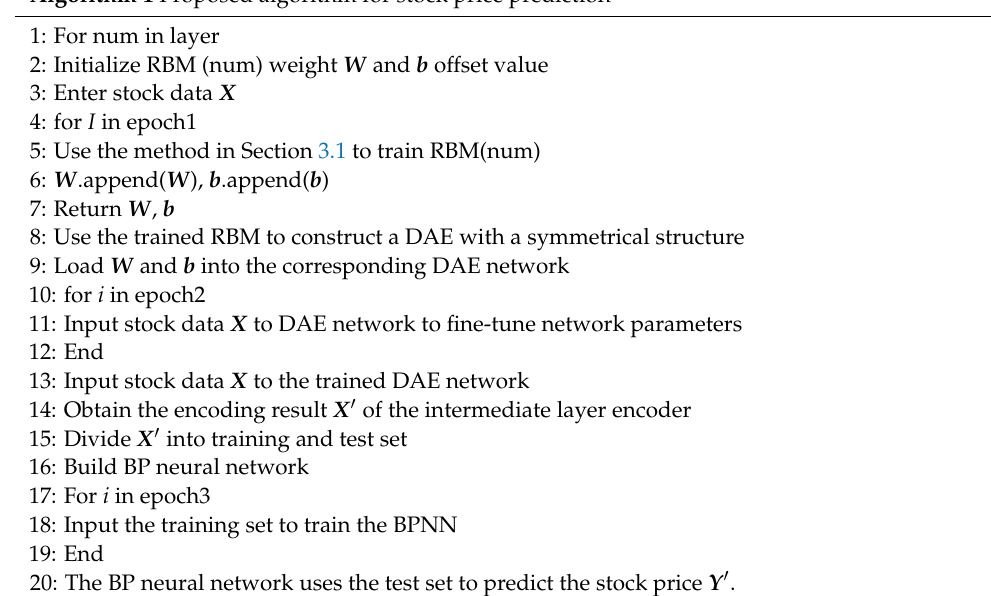
Algorithm 1 Proposed algorithm for stock price